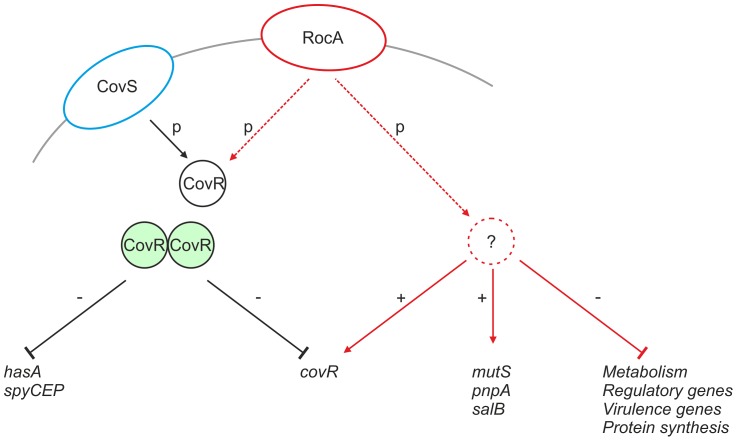
Proposed mechanism of RocA mediated activity.CovR (black circle) is phosphorylated directly by CovS (blue ellipse), which induces CovR dimerization (green circles) and transcriptional repression of hasA and spyCEP, as well as auto-repression of covR. RocA (red ellipse) regulates expression of a number of gene products (solid red lines). RocA promotes transcription of covR potentially via an intermediate regulator (red dashed circle). RocA also promotes expression of proteins that are not part of the CovR regulon, whilst inhibiting many others. Such regulation may also require kinase action and an intermediate regulator.